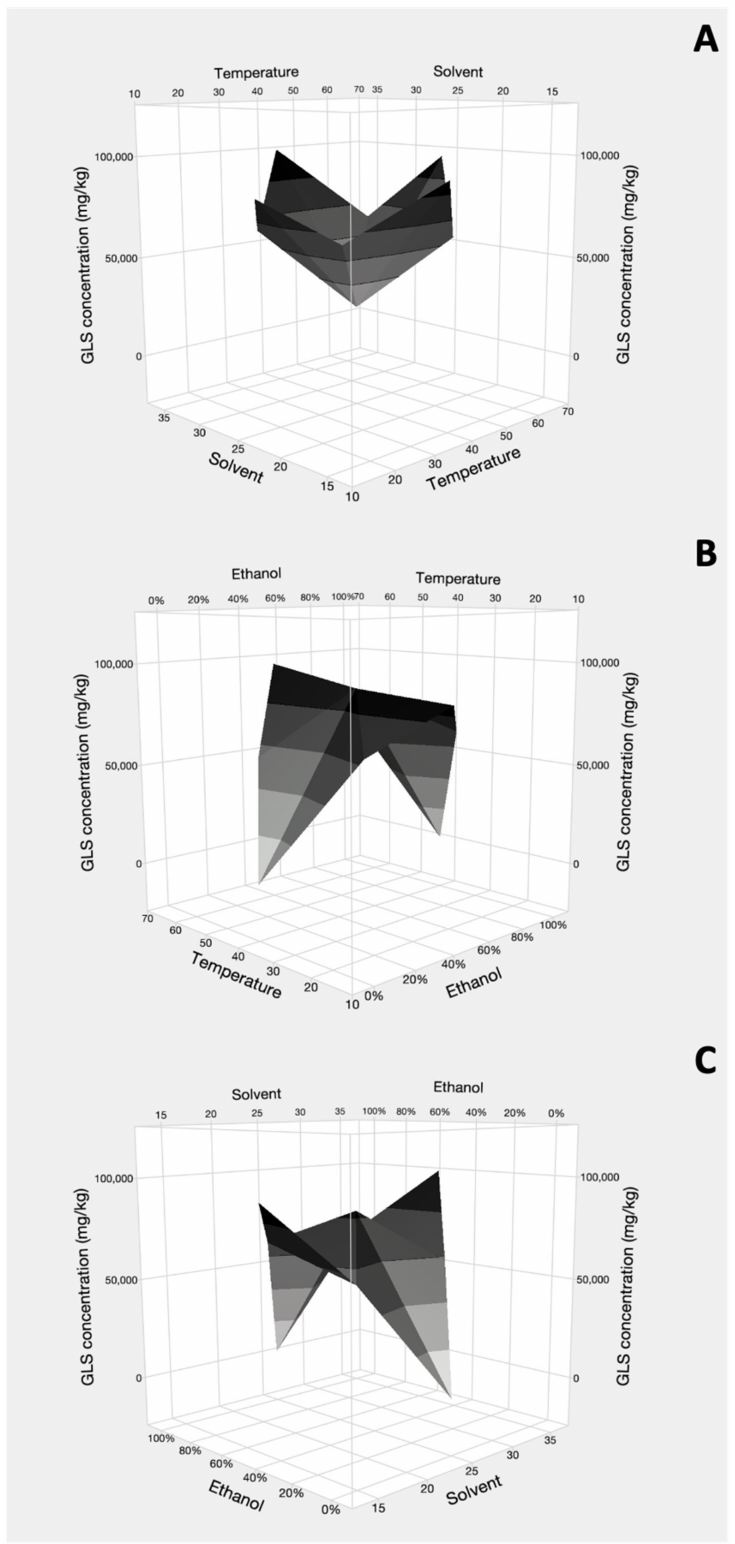
Figure 1. Response Surface graphical analysis for ( A ) Temperature-Sample: Solvent; ( B ) Temperature- %Ethanol; and ( C ) Sample: Solvent-%Ethanol against the Total Concentration of GLS (mg/kg DW) response variable. Significance is established at p <